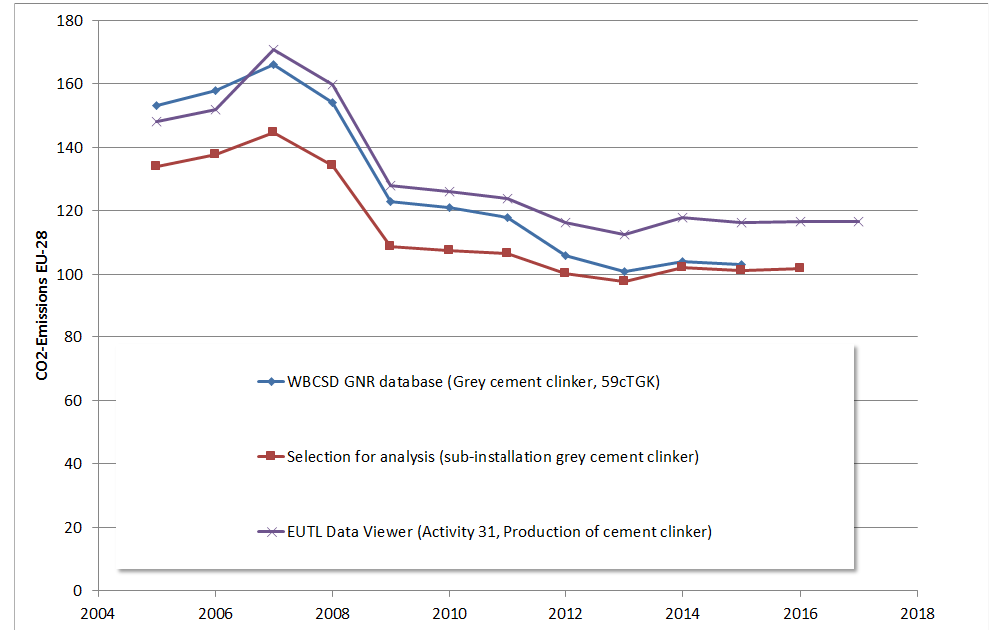
Figure 5. Overall greenhouse gas emissions of cement (Mt CO 2 -equ.) from three different sources. Source: Selection for analysis from EUTL [19]; own calculations, EUTL Data Viewer [25], WBCSD GNR database